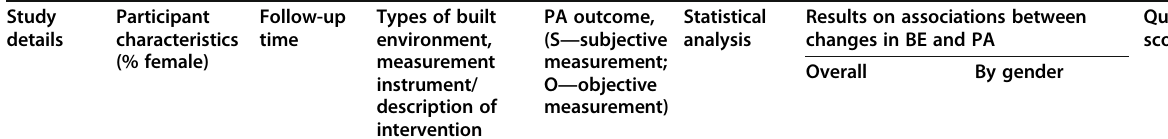
Table 1 Study characteristics